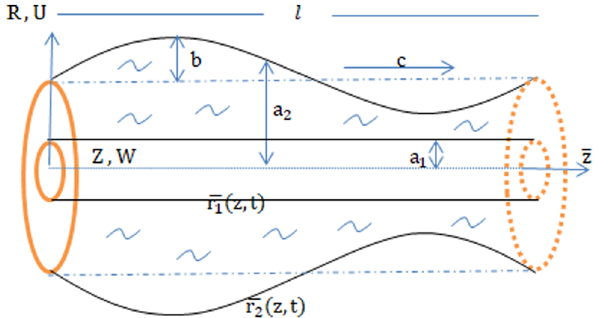
Figure 1: The problem